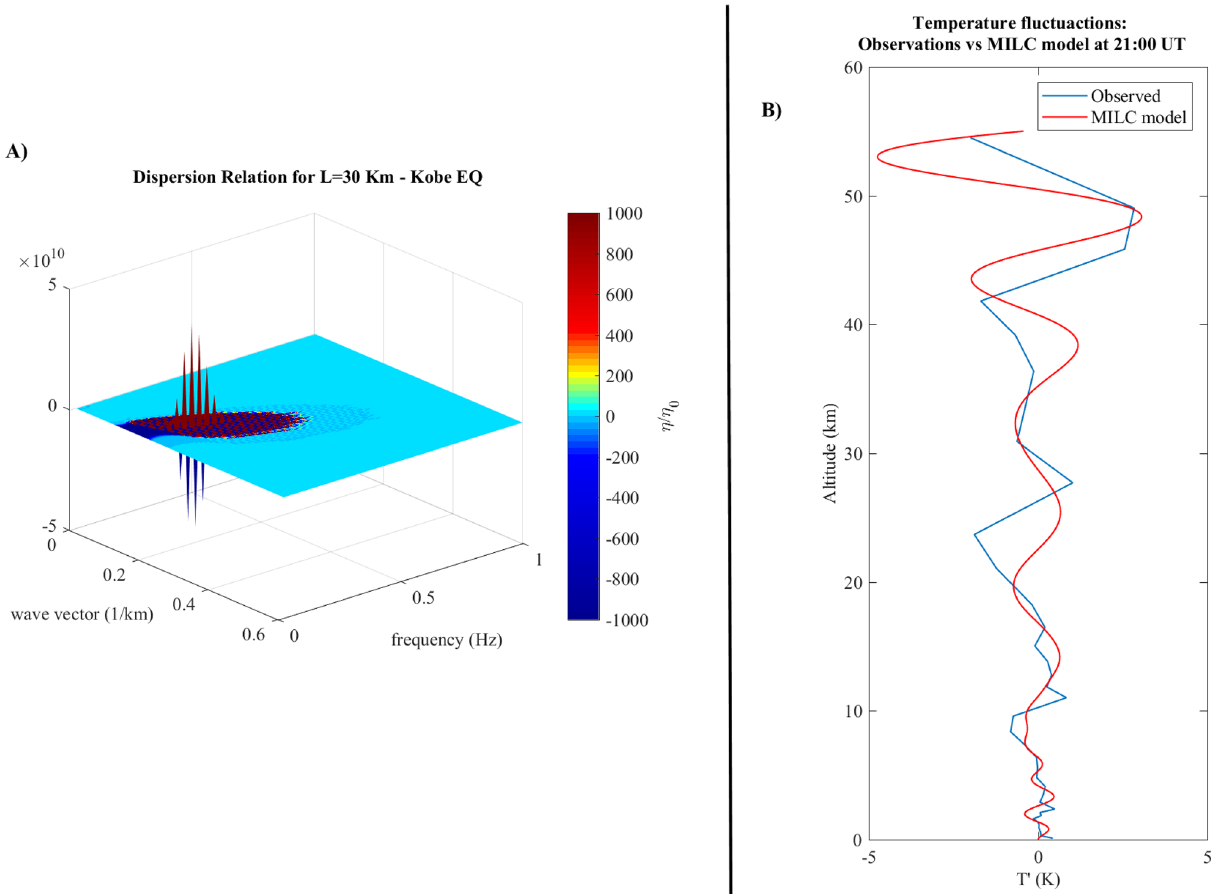
Figure 2. Box ( A ) Tri-dimensional dispersion relation evaluated for the Kobe Earthquake using the parameters in Table 1. The dashed line represents the parameter c 0 / 2 h . Box ( B ) Fluctuations of the vertical temperature profile over the EQ epicenter (blue line) superimposed to the modelled temperature previsions at 21:00